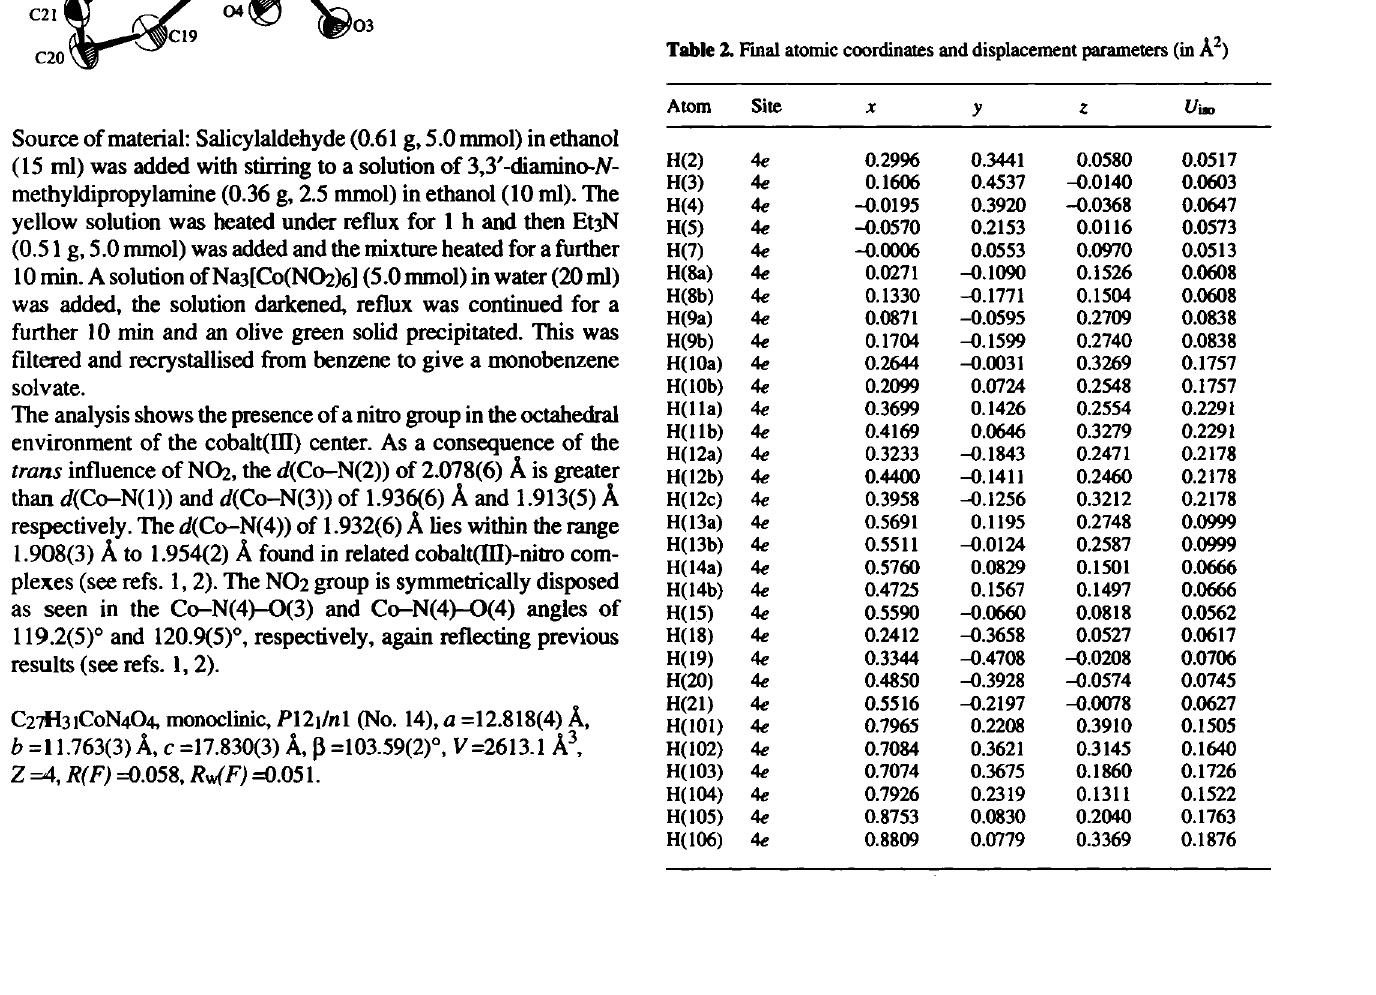
Table 1. Parameters used for the X-ray data collection Crystal: